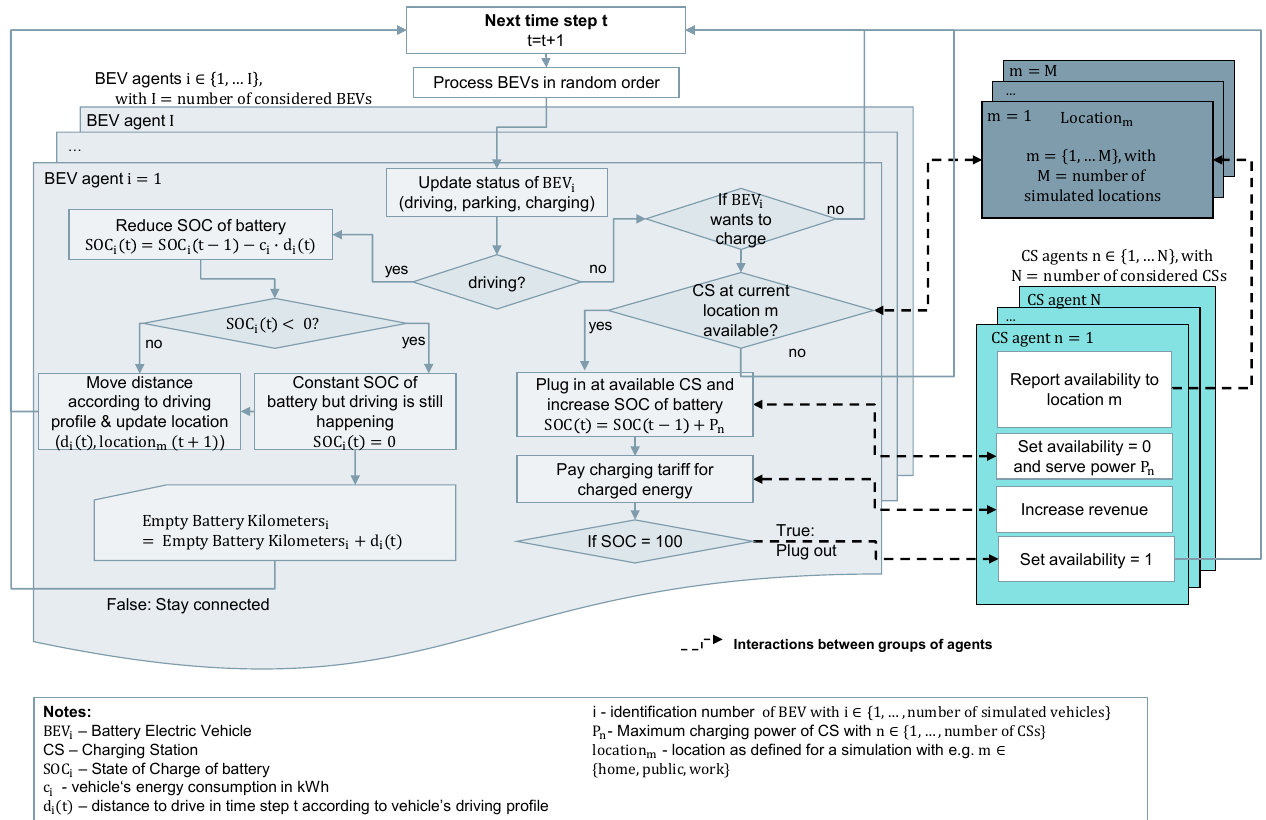
Figure 2. Flow chart of Agent-based e-Mobility Model focusing on the BEV actions and the interactions between agents. Each BEV executes actions based on its state—driving, parking, charging—within the The simulation procedure is based on discrete time steps, whereby in each time step, time step. The basic principle of that is described in Husarek et al., 2019 [39]. several decisions, actions and interactions are simulated. BEVs are processed consecutively It should be emphasized that vehicles continue driving even if the value of their SOC within a random order. This order changes within each time step to ensure that the would turn negative. In this case, the SOC is fixed at zero, according to Figure 2. Although this assumption does not hold true for full battery electric vehicles in reality, we measure